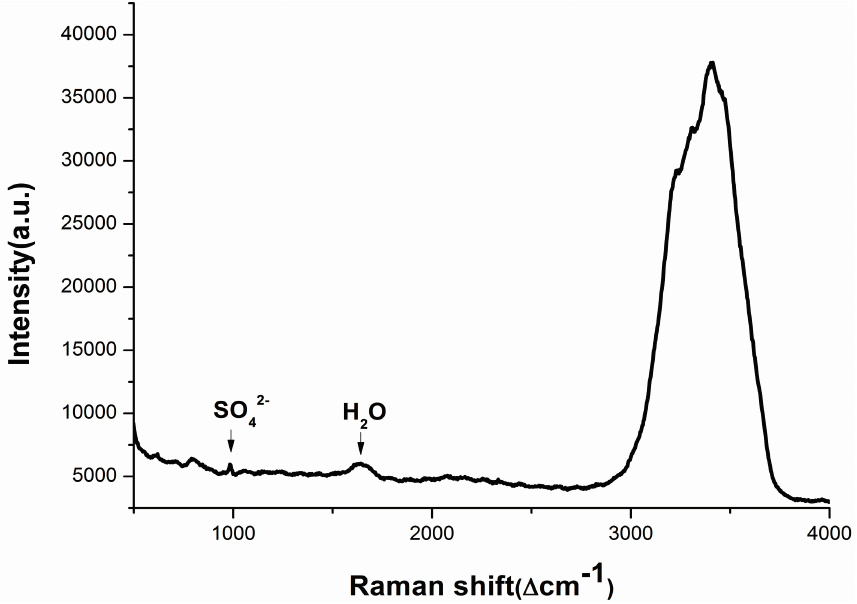
Figure 2. Typical Raman spectrum of the pore water samples.